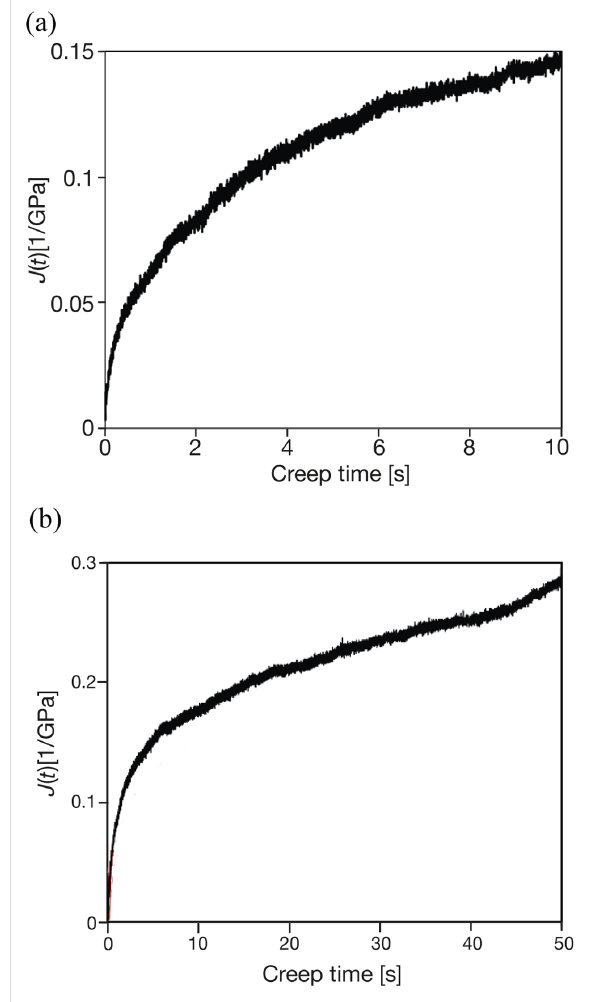
Figure 10: AFM probe creep test showing the creep compliance calculated using Equation 11 for PMMA. (a) A 10 second creep test. (b) Longer time showing effect of plastic yield (see text), in deviation of curve at long